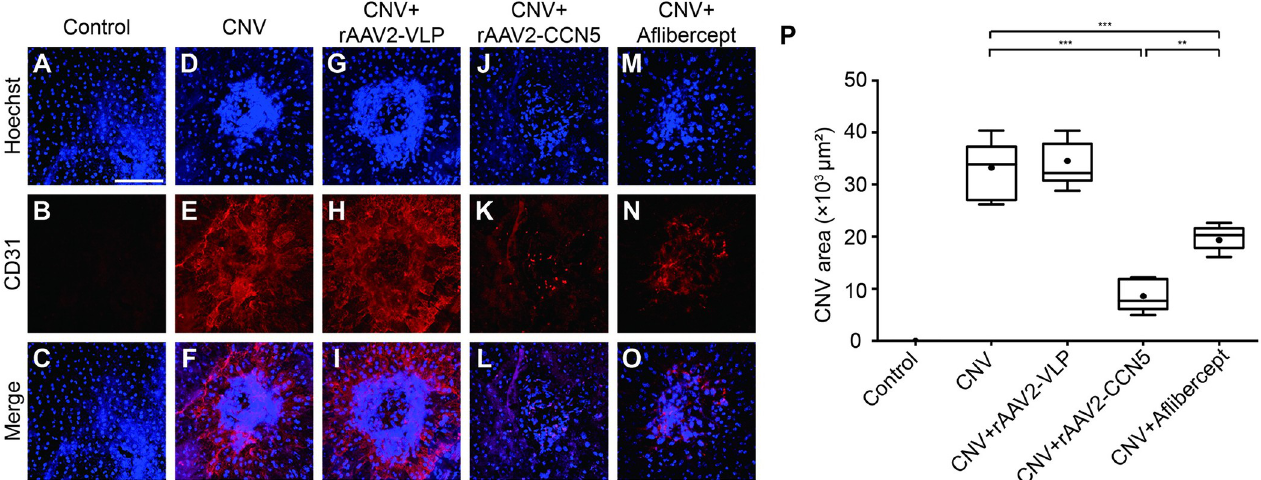
Fig 3. Assessment of CNV by immunostaining for CD31. (A~O). Flat mounts of RPE/choroid complex were immunostained for CD31. Hoechst dye was used for staining of nuclei. Representative images are shown. Scale bar, 100 μ m. (P). CD31-positive areas were quantified using ImageJ algorithm and plotted. Bars show the mean ± SD. (n = 6 spots per group; one-way ANOVA; �� P < 0.01, ��� p < 0.001).